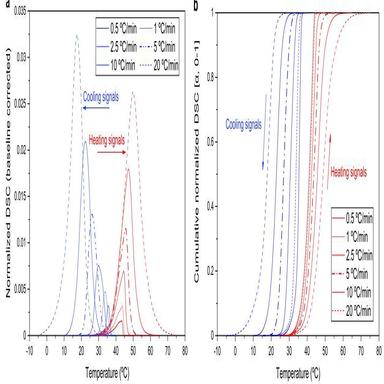
Normalised DSC signals associated with phase change of PEG1500. a, Normalised DSC signals after baseline correction. b, Cumulative normalised DSC signals representing (liquid mass) phase fractions, from 0 (fully solid) to 1 (fully liquid).